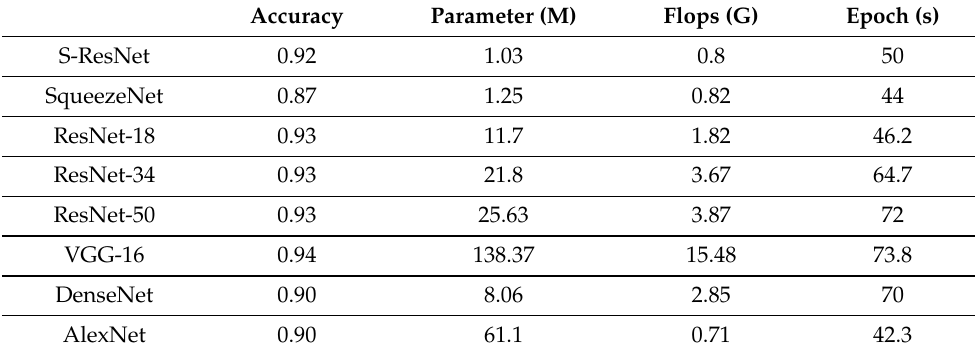
Table 11. Comparisons of classification performance with different models.